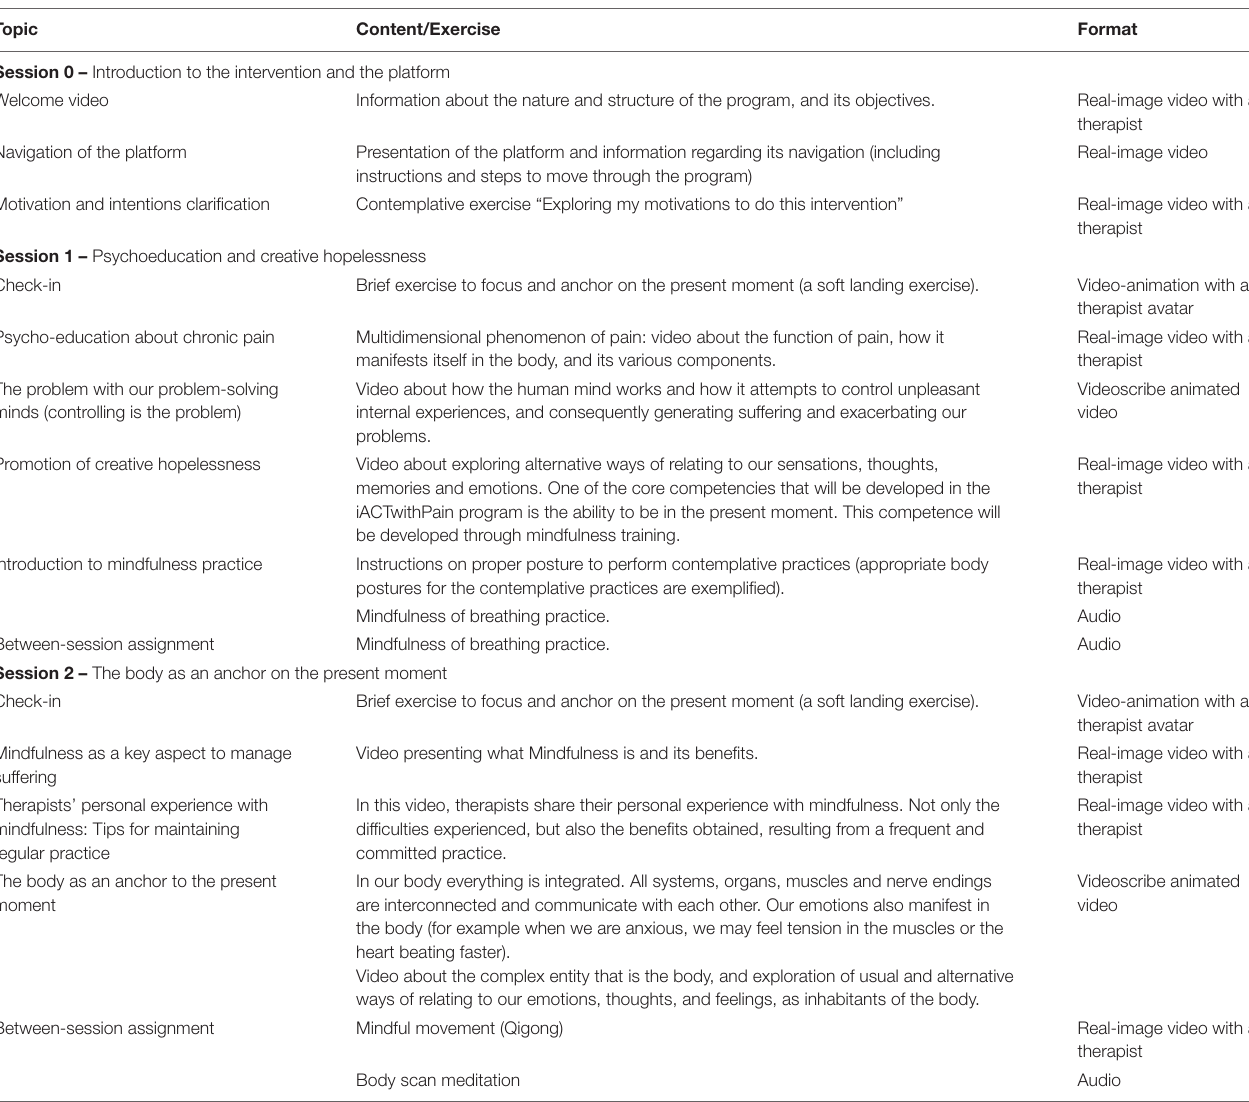
TABLE 1 | Structure and contents of session 0, 1, and